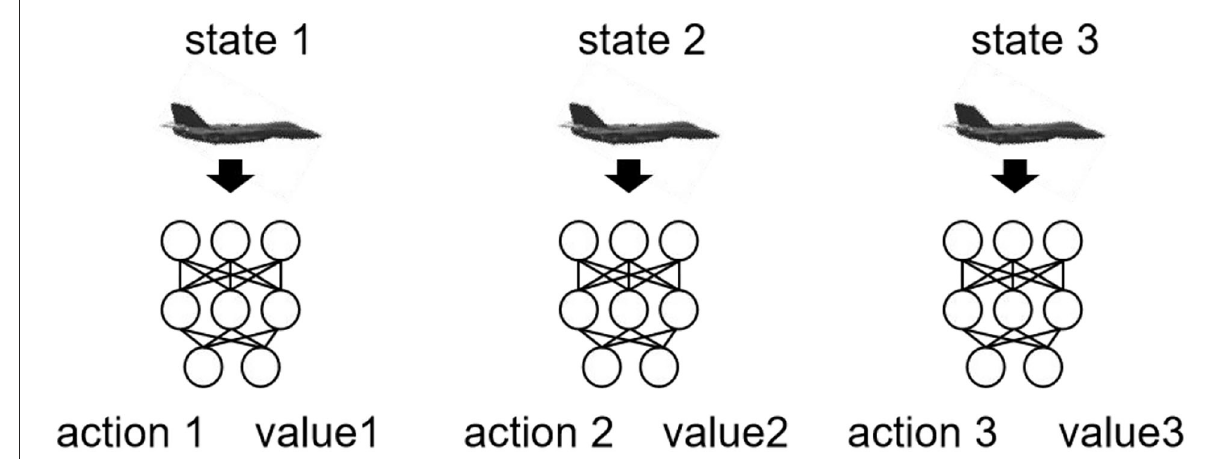
FIGURE4 Training neural networks.